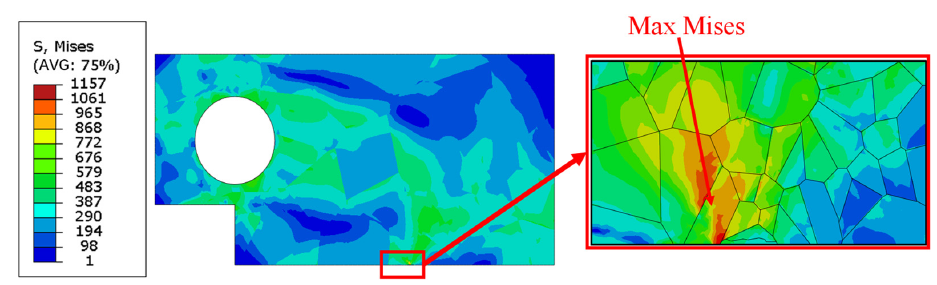
Figure 12. Calculation results of 40 kN CT model at − 100 °C .